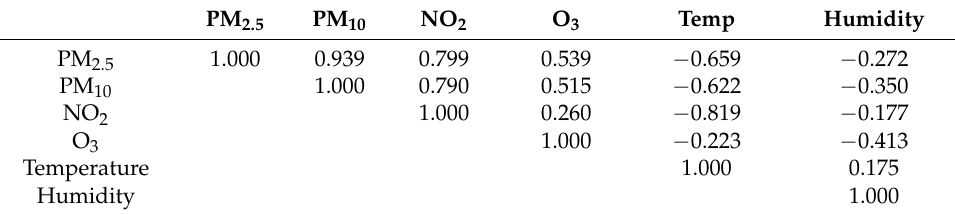
Table 3. Spearman correlation coefficients for air pollutants and weather conditions during the study